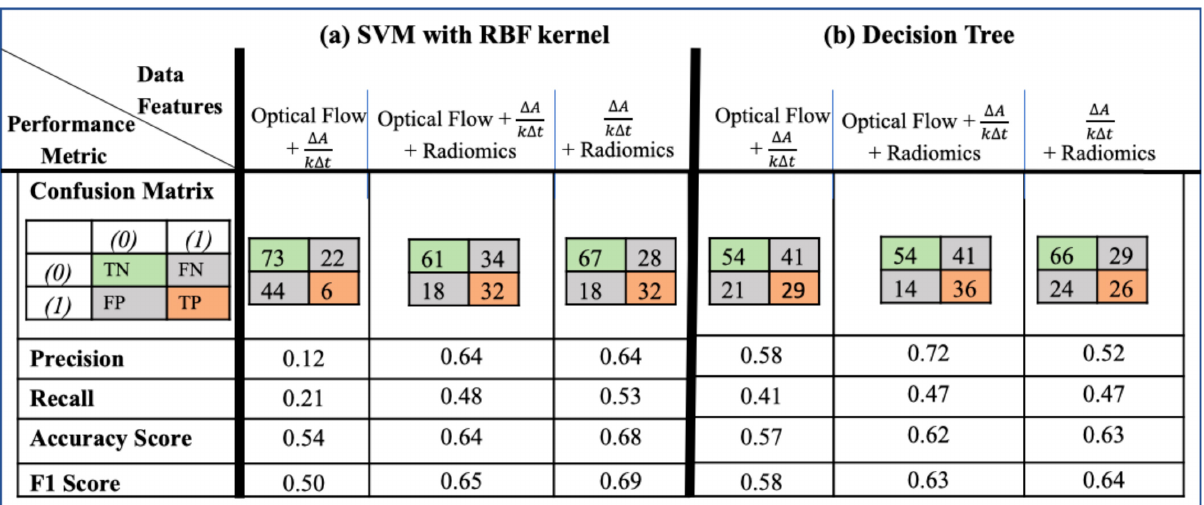
TABLE 3 Performance of machine learning data-driven approaches, with methods (a) support vector machines (SVM) using radial basis function (RBF) kernel and (b) decision tree, for different combinations of the optical flow, rate of change of myocardial area and radiomics data.The SVM model had the best performance in terms of accuracy and F1 scores when the input consists of the rate of change of myocardial area and the radiomics data. The DT model had the best in terms of the precision score when the input consists of the optical flow, the rate of change of myocardial area and the radiomics